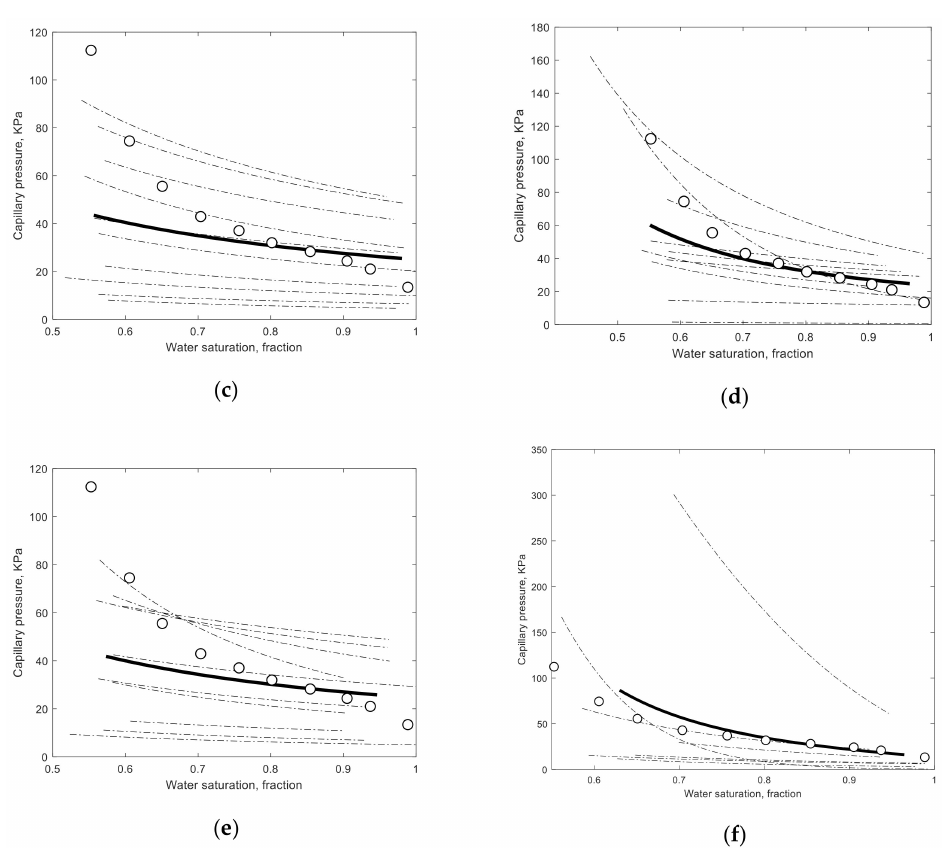
Figure 11. Comparison of interpreted versus true capillary pressure curves at varying pressure drops of ( a ) 0.3 MPa, ( b ) 0.25 MPa, ( c ) 0.2 MPa, ( d ) 0.15 MPa, ( e ) 0.1 MPa, and ( f ) 0.05 MPa: open circles are reference data points; dashed lines are 10 independent solution runs; and solid lines are averages of the independent